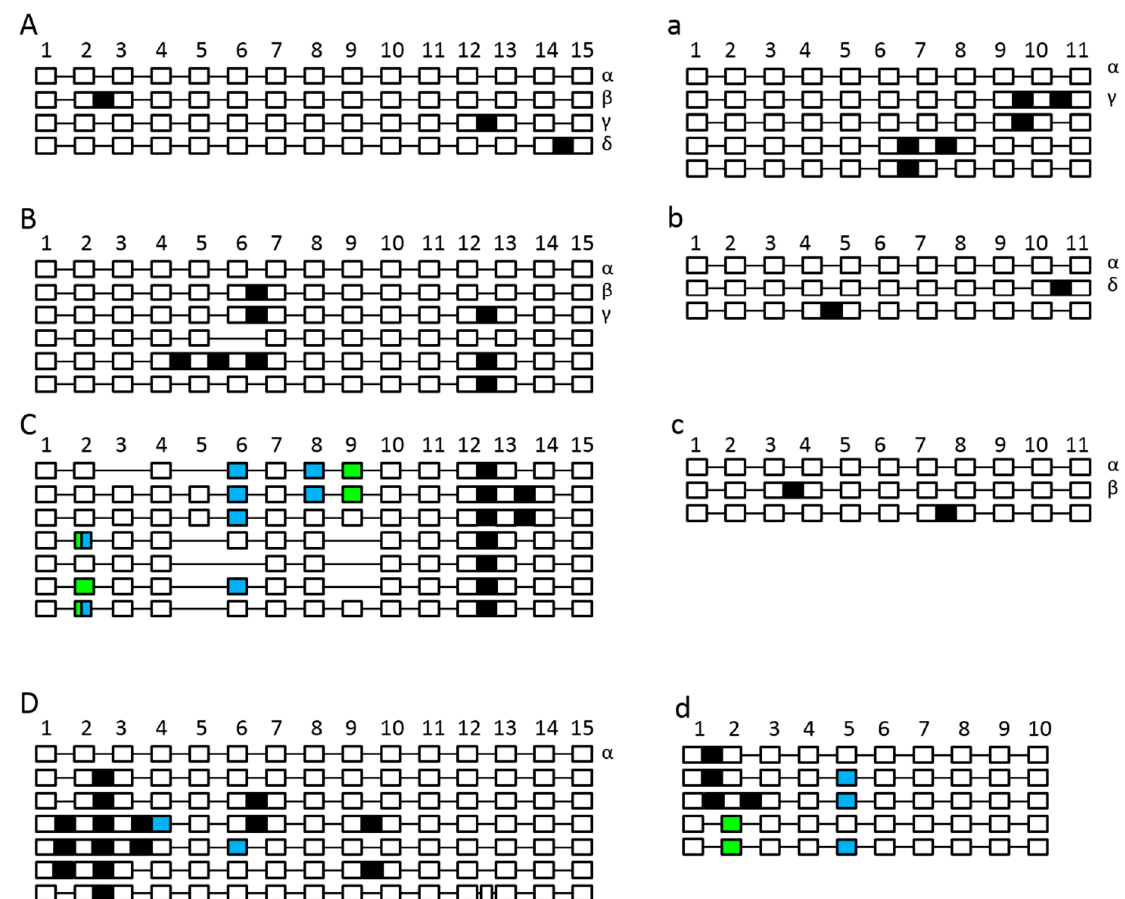
Figure 10. Schematic unscaled schema of different splice forms of SPO11-1 ( A – D ) and -2 ( a – d ). Arabidopsis thaliana ( A , a ), Brassica rapa ( B , b ), Carica papaya ( C , c ) and Oryza sativa ( D , d ). SPO11-1 ( A , B , C , D ) and -2 ( a , b , c , d ) have been reintegrated into Arabidopsis . Exons are numbered and shown as white blocks, spliced introns as black lines. Intron retention events are illustrated as black boxes, alternative 5 ′ splice site selection are shown as blue boxes and alterative 3 ′ splice site selection as light green boxes. In the case of exon skipping, the corresponding white box is missing. Previously known splicing forms are named in Greek letters, see [33].